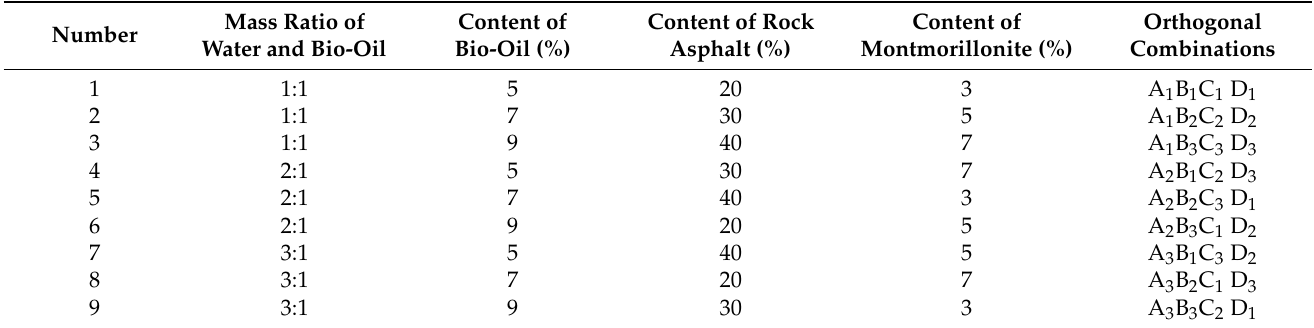
Table 6. Combinations of orthogonal test L9(34).